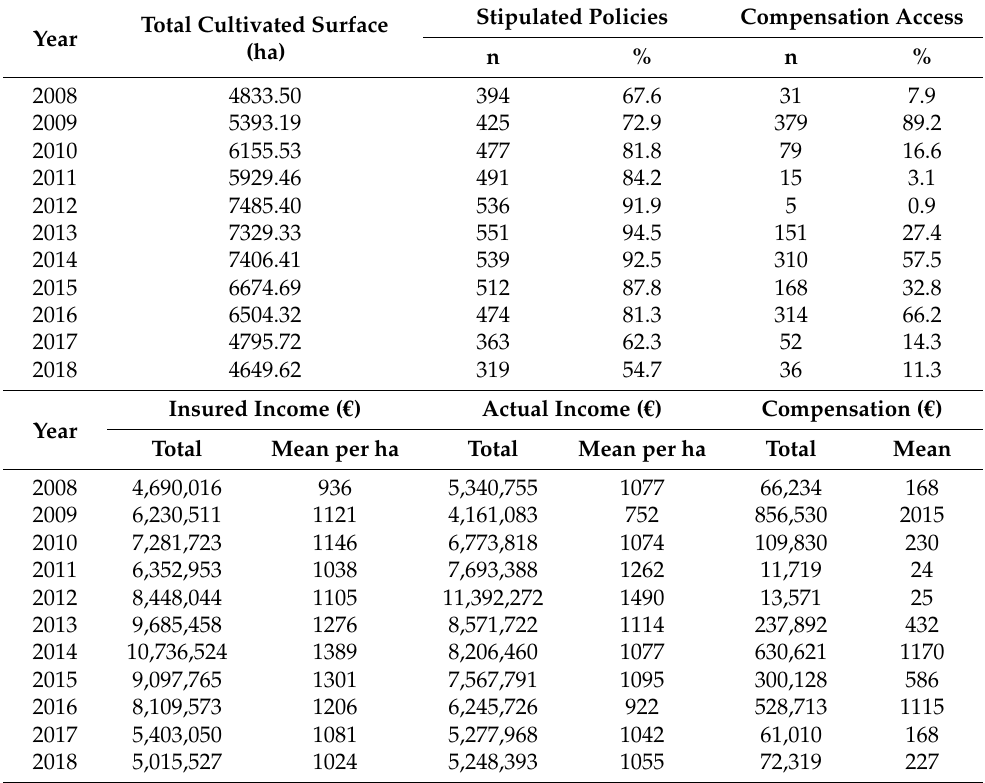
Table 2. Common wheat: summary of revenue policy application in 2008–2018.